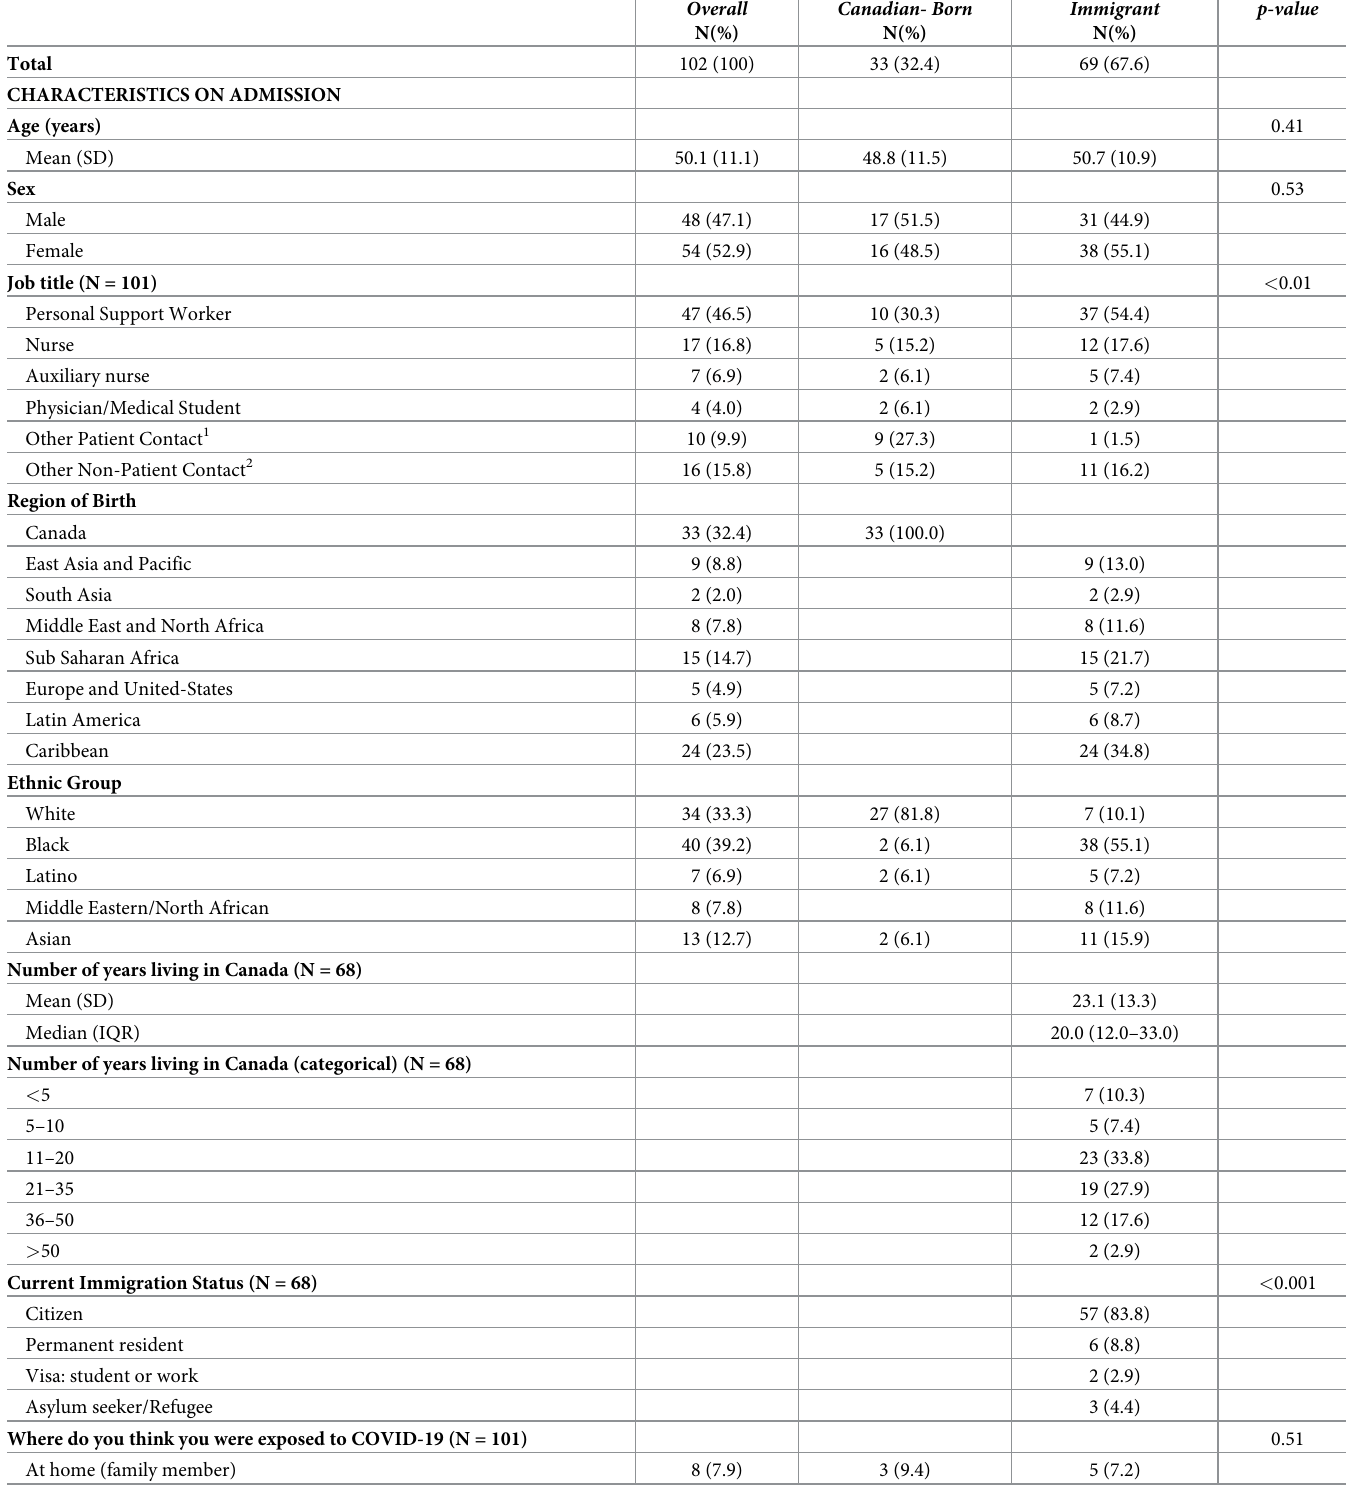
Table 4. Health care worker phone survey data stratified by immigration